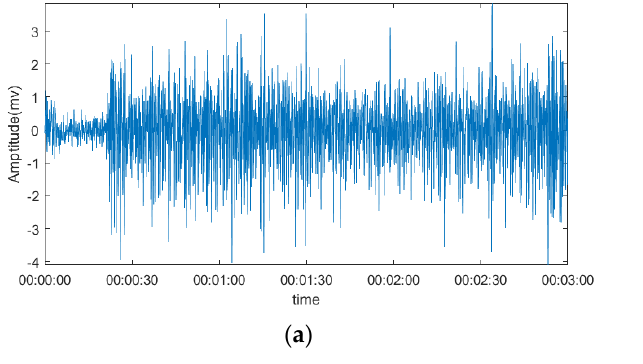
Figure 3. The grasping movements [27].